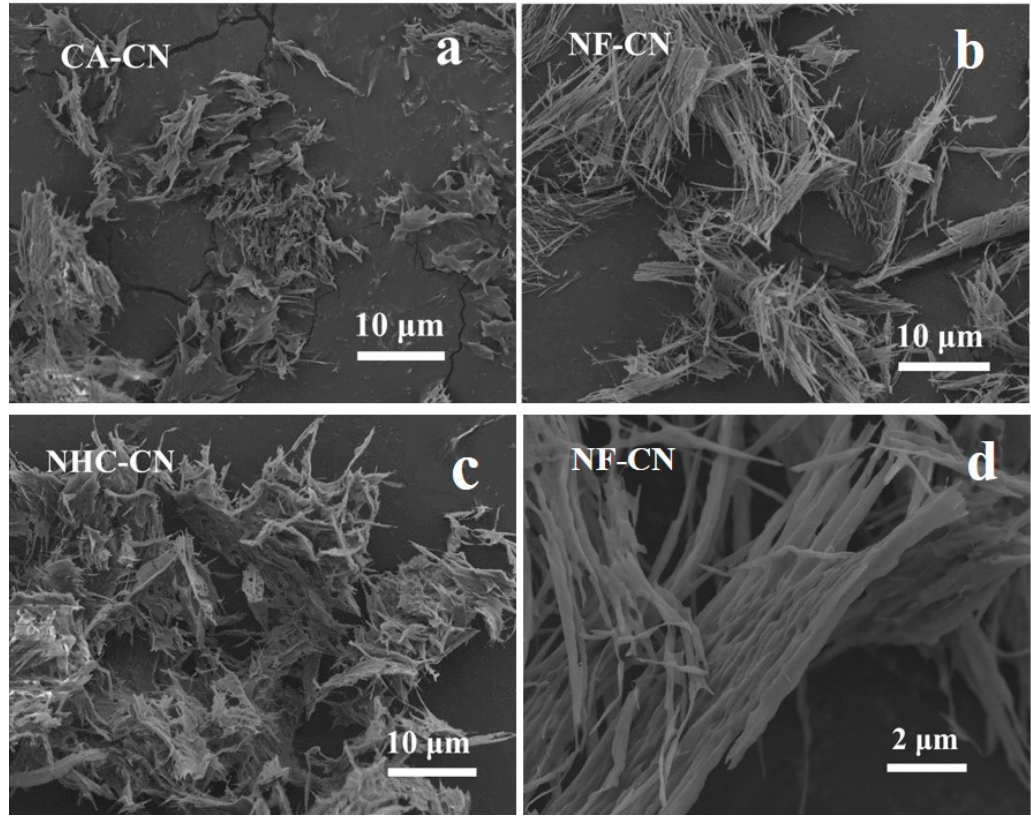
Figure 7. SEM images of ( a ) CA-CN (cellulose acetate modified Ce-C 3 N 4 ), ( b ) NF-CN (NH4F modified Ce-C 3 N 4 ), and ( c ) NHC-CN (NaHCO 3 modified Ce-C 3 N 4 ). ( d ) high-magnification SEM images of NF-CN.